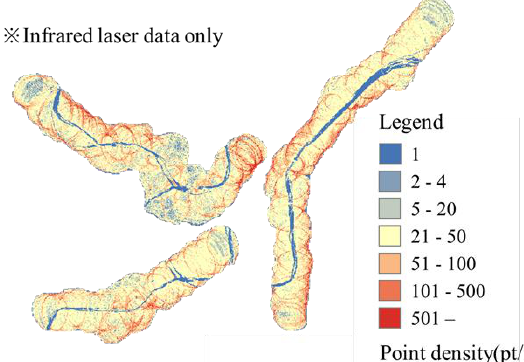
Figure 12. Point density in the practical